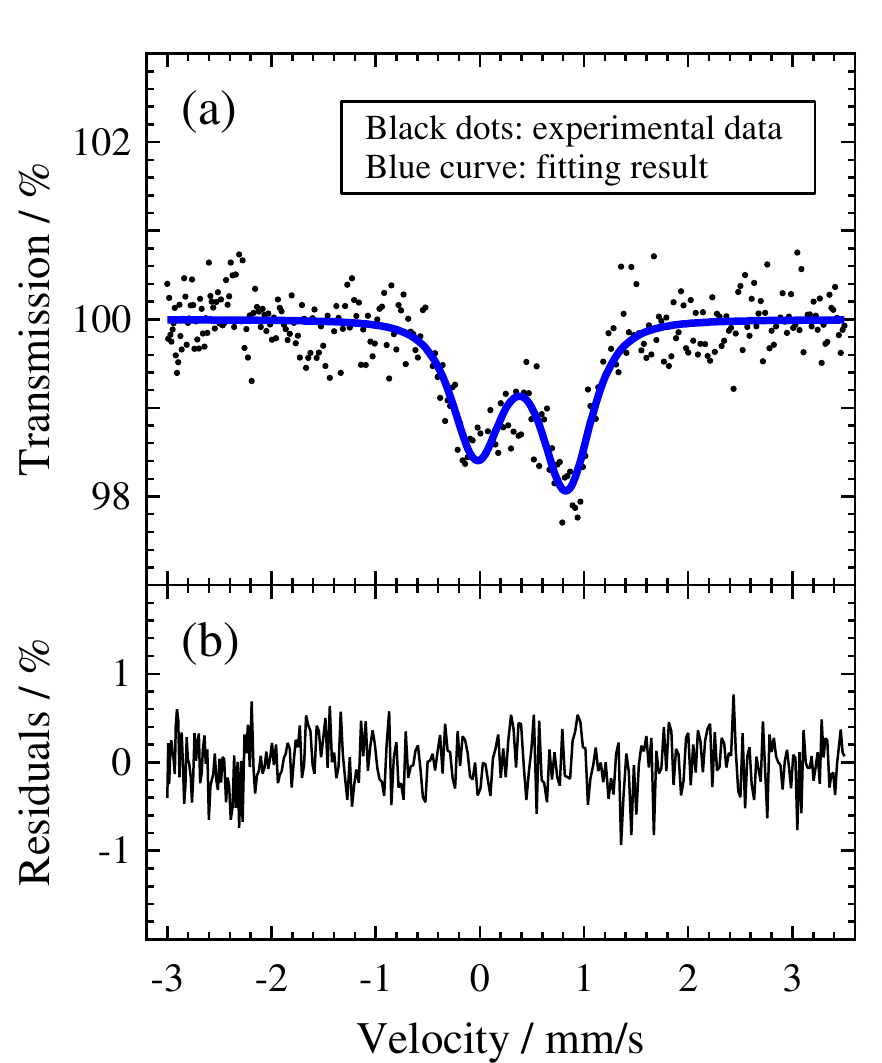
Figure 2. ( a ) Mössbauer spectrum of the present (Fe 3+ , Al)-bearing bridgmanite single-crystal and ( b ) the fitting residuals. The software IGOR Pro (Version 6.2, WaveMetrics, Inc., Lake Oswego, OR, USA, https:// www. wavem etrics. com) was used for data